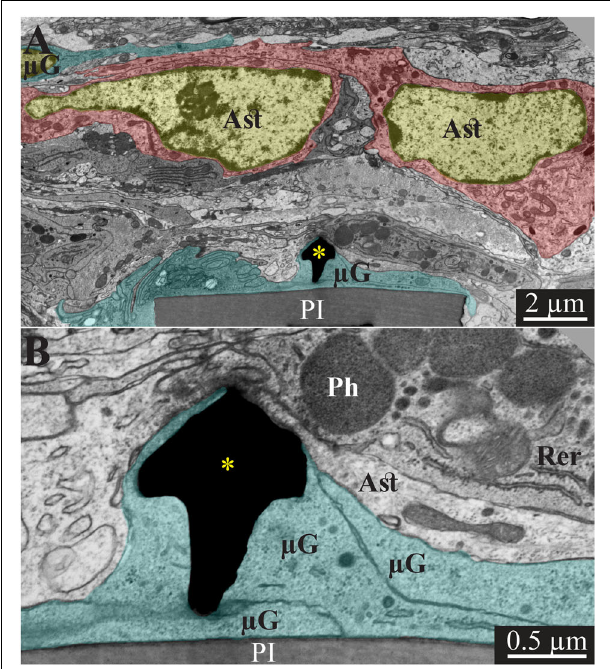
FIGURE 4 | Transmission electron microscope images of a gM µ E (black mushroom shaped profiles A,B ) tightly engulfed by microglia, 2 weeks after PPMP implantation. Note the thin 0.5–1 µ m layers of microglia branches that adhered tightly to the PI surface and the gold mushroom microelectrode (cyan). Additional microglia layers characterized by dark cytoplasm (not labeled in color) contained a rough endoplasmic reticulum and dark inclusions which plausibly were lysosomes and lipofuscine granules. Astrocyte branches characterized by sparse electron dense material containing intermediate filaments invaded in between the microglia branches but did not form direct contact with the implant. Note that the TEM section is slightly tilted in respect to the long axis of the gM µ E. For that reason the mushroom’s stalk appears to taper toward the polyimide platform and looks like it end in the tissue rather than attached to polyimide. Astrocyte cell bodies resided micrometers away from the implant. PI, polyimide ribs; gM µ E, yellow asterisks; µ G, microglia; Rer, rough endoplasmic reticulum; Ast, astrocyte; Ph, phagocytosed materials. An unmarked copy of this figure is presented as Supplementary Figure 4